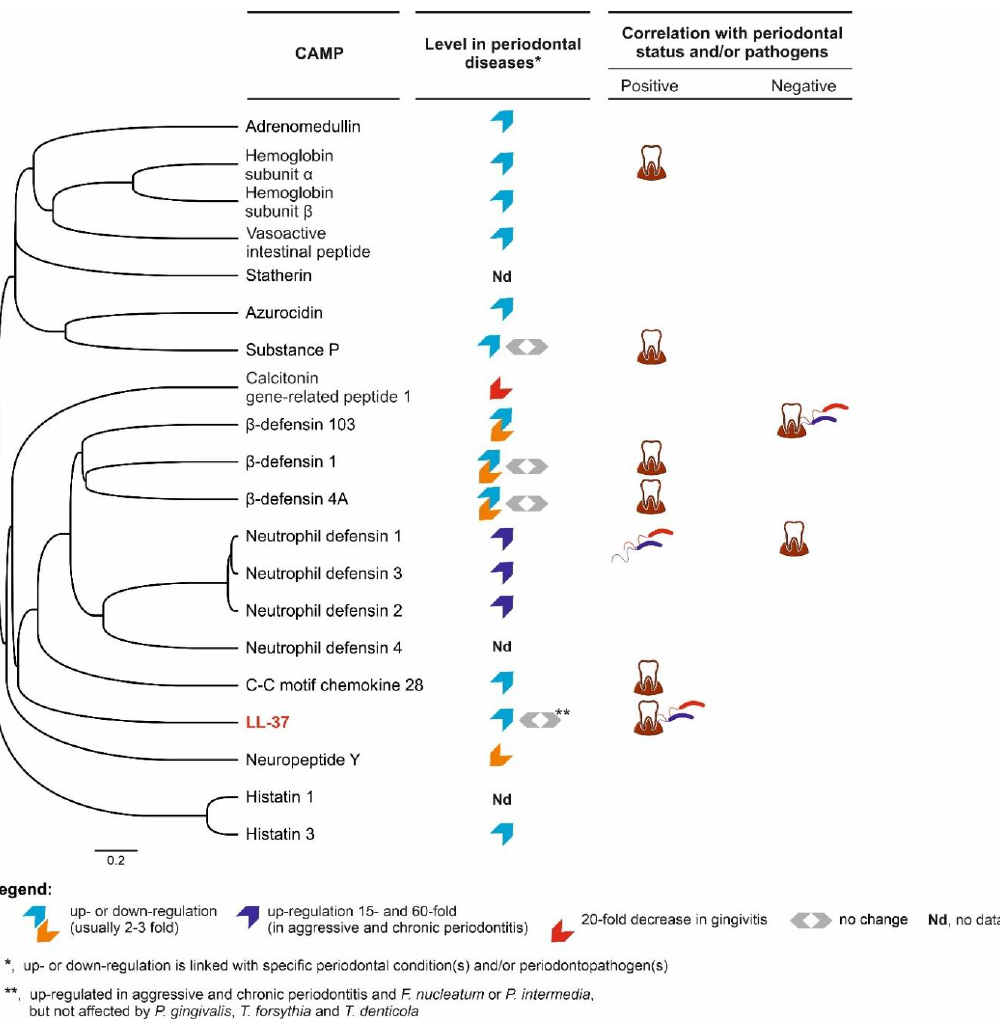
Figure 10. Comparison of 20 human cationic antimicrobial peptides (CAMPs) present in oral cavity, including LL-37 (highlighted in red), based on the amino acid sequence similarity as well as changes in their expression in periodontal conditions and correlation with the periodontal status and/or bac- terial pathogens. The alignment of hCAMP sequences (only aa representing active peptides were aligned, i.e., without signal sequences and/or proteolytically cleaved fragments) and their phyloge- netic tree was performed using MAFFT version 7 server (based on the L-INS-I alignment algorithm and average linkage — UPGMA, respectively) [33]. The data regarding the hCAMP expression levels ( , i.e., up- or downregulation) and their correlation with the periodontal status ( , represented by probing depth, PD; bleeding on probing, BOP; clinical attachment loss, CAL; plaque index, PI; gingival index, GI; papillary bleeding index, PBI) and microbiological parameters ( , i.e., changes in occurrence of P. gingivalis , T. forsythia , and T. denticola ) were obtained from the references [33,33,33].